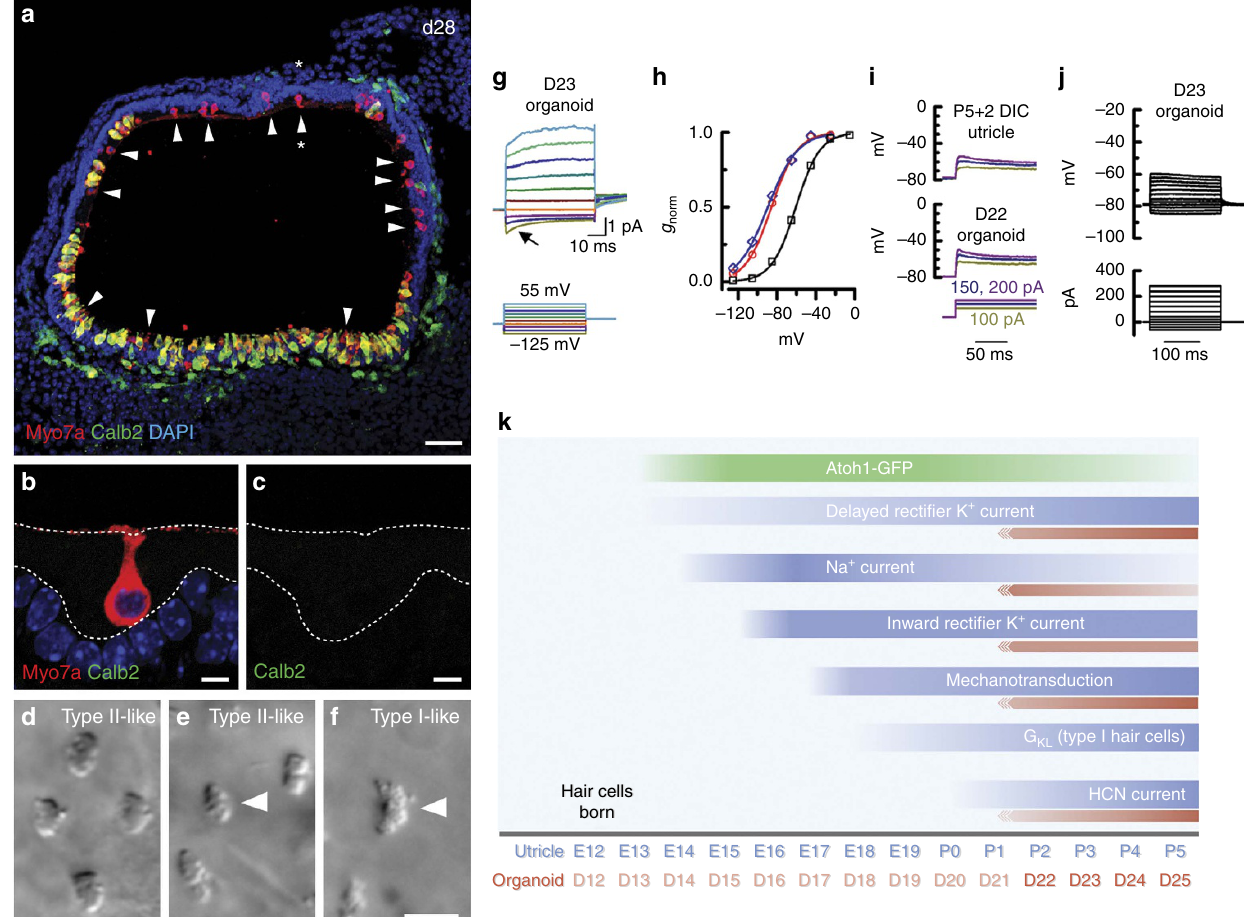
Figure 6 | Evidence of Type I hair cells in ES cell-derived organoids. ( a ) Confocal image of a day 28 organoid reveals numerous Myo7a þ , Calb2-